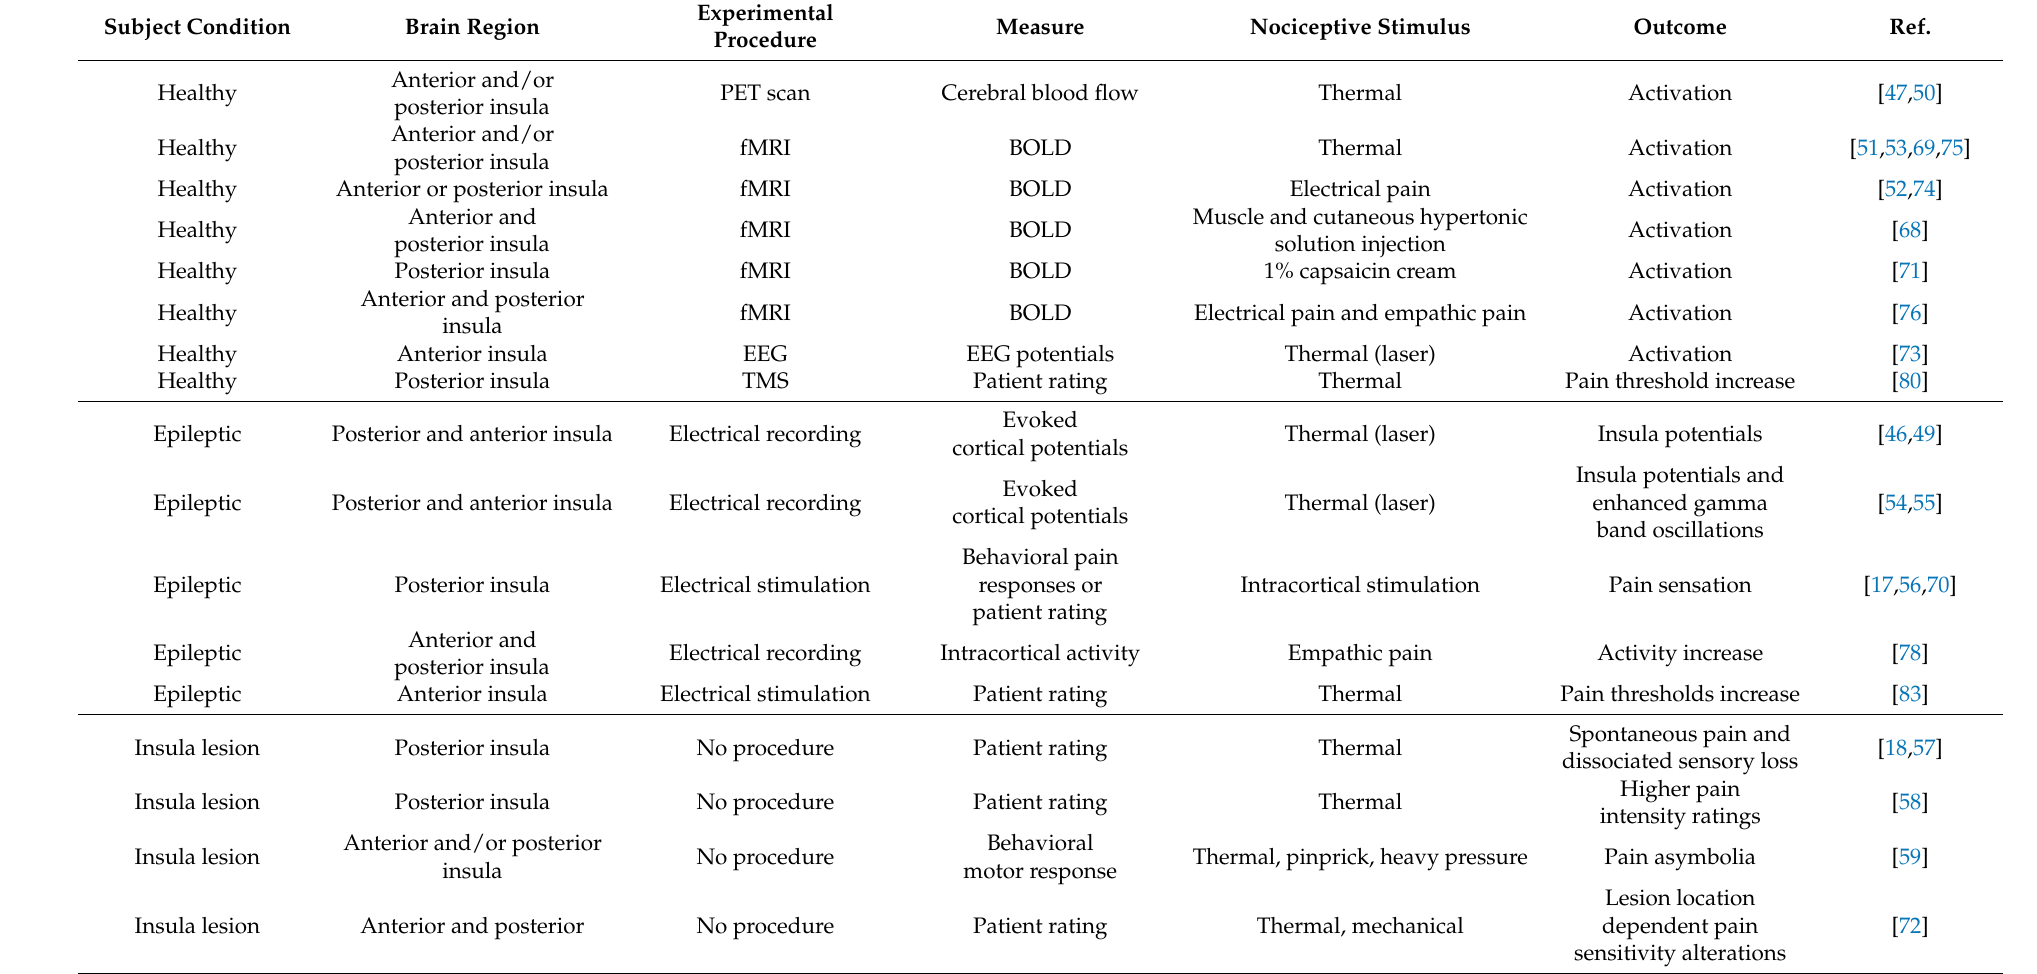
Table 1. Overview of human studies on the role of the insula in